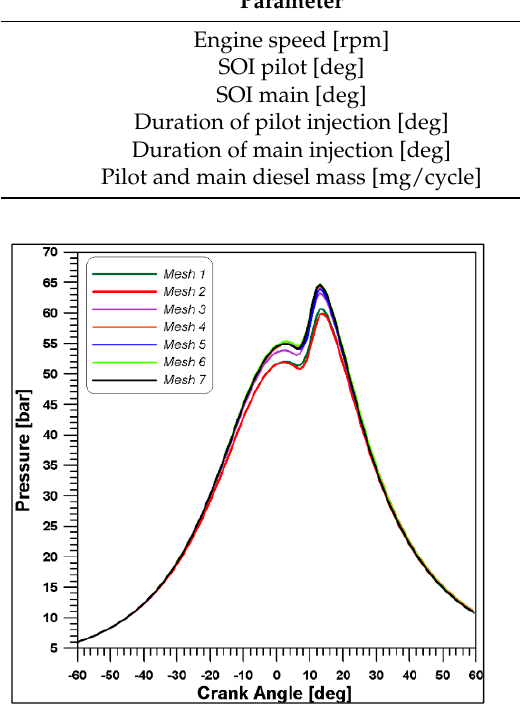
Figure 9. Pressure for the different meshes.